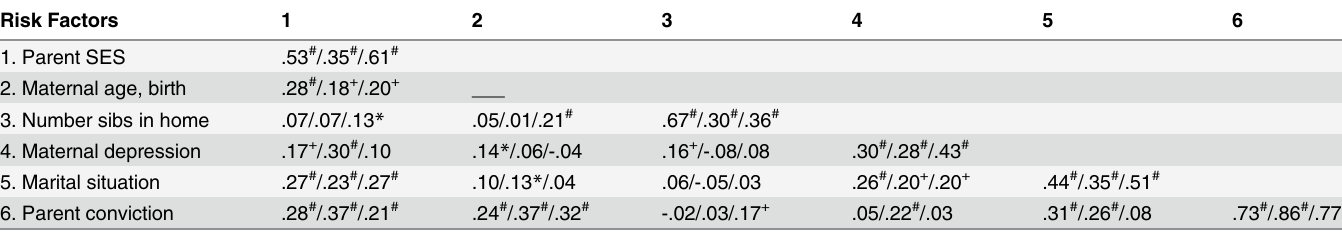
Table 1. Partial Intercorrelations and Stability Coefficients among Risk Factors.